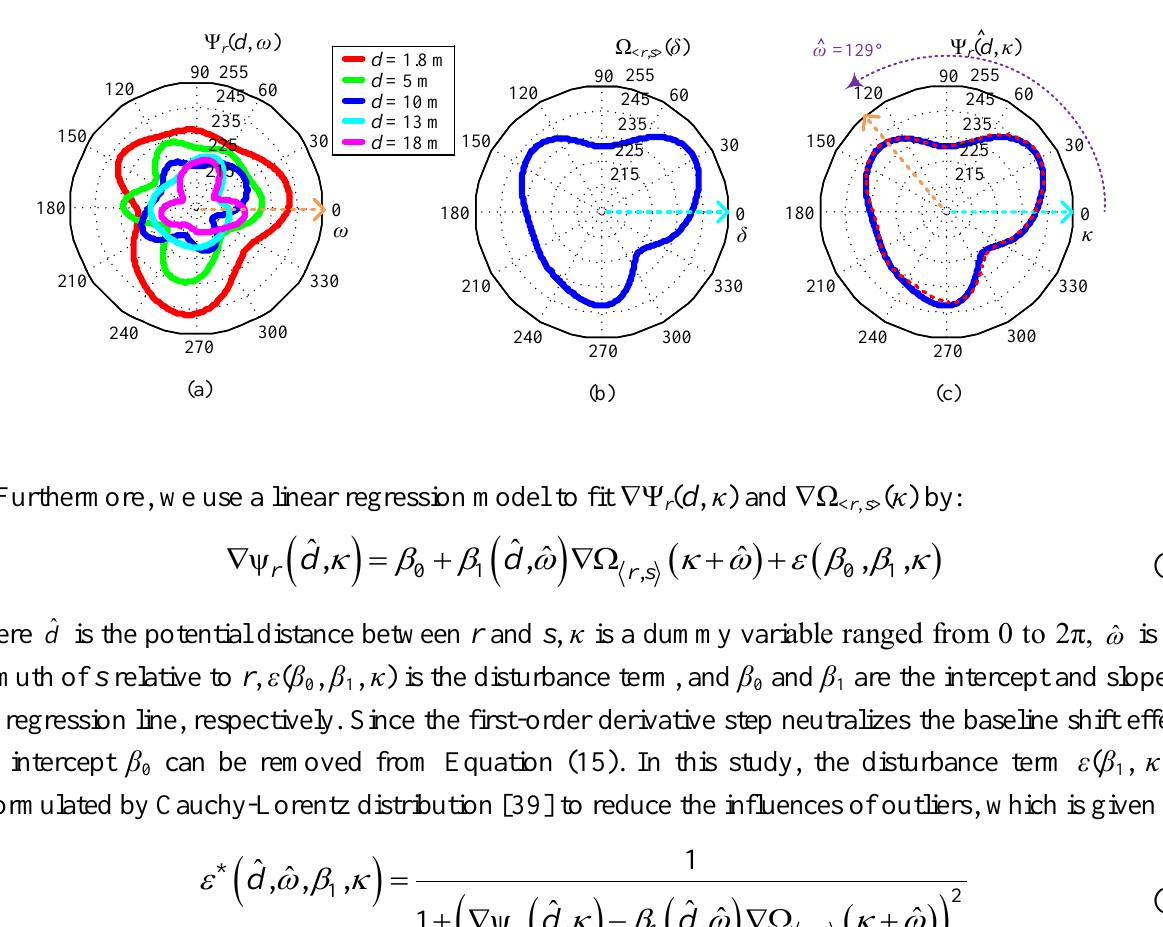
Figure 5. Examples of RSSI patterns. (a) Reference standard RSSI patterns Ψ given reference node and five patterns measured when the sensor node and the reference node are distanced by 1.8 m, 5 m, 10 m, 13 m, and 18 m; (b) An RSSI pattern Ω between the aforementioned reference node and a sensor node with unknown coordinates; (c) By matching Ω ( δ ) with Ψ ( d , ω ), the distance and angular direction of the sensor < r , s > r node relative to the reference node estimated at 1.8 m and 129° counterclockwise,